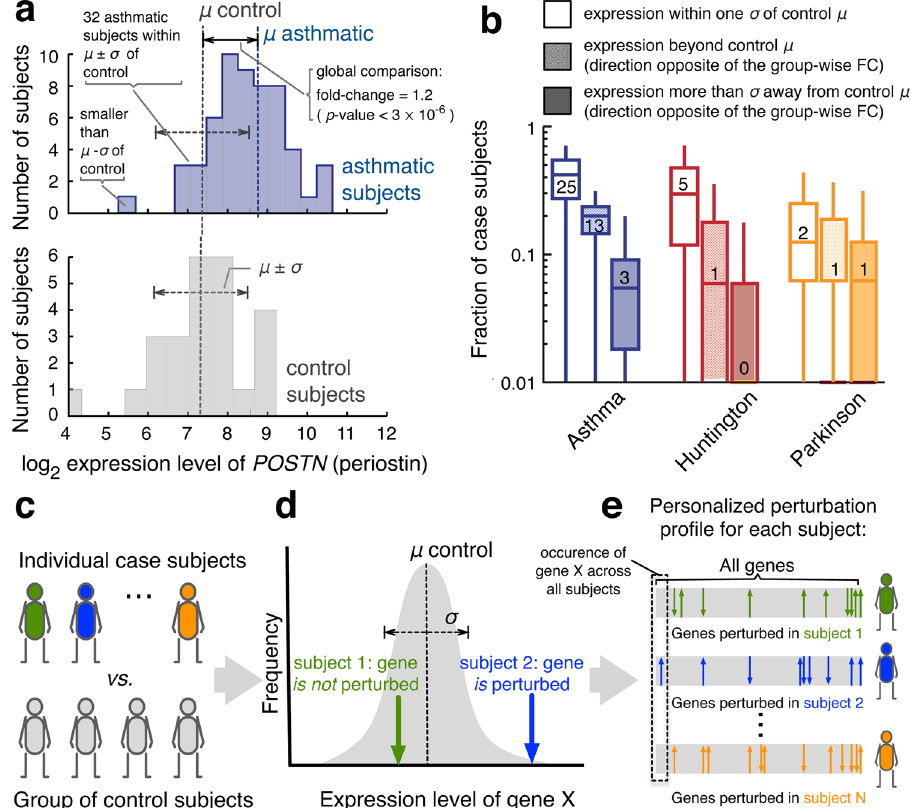
Fig. 1 Personalized gene expression analysis. a Example of the distribution of expression levels for the asthma biomarker POSTN . While the group-based comparison (FC = 1.2, p -value < 3 × 10 − 6 ) suggests a global up-regulation of POSTN , many asthmatic individuals exhibit normal or even down-regulated POSTN levels. b Fraction of case subjects in which genes that are denominated as being DE in a standard group-wise analysis display normal expression levels, or expression levels that suggest a dysregulation in the opposite direction. The distributions show the respective fractions over all group-wise DE genes. All whisker bars throughout this manuscript indicate the 5, 25, 50, 75, and 95th percentiles of the respective distributions. Small numbers within the bars indicate the absolute number of patients that the respective median fraction corresponds to. c – e Illustration of the proposed approach towards individual perturbation pro fi les: instead of comparing two groups of case and control subjects, we compare each case subject individually with the background of control subjects ( c ). Genes whose expression level is suf fi ciently far from the range observed in the control subjects d are denoted as perturbed in the respective individual. Together, the perturbed genes constitute a personalized, i.e. subject speci fi c “ barcode ” ( e